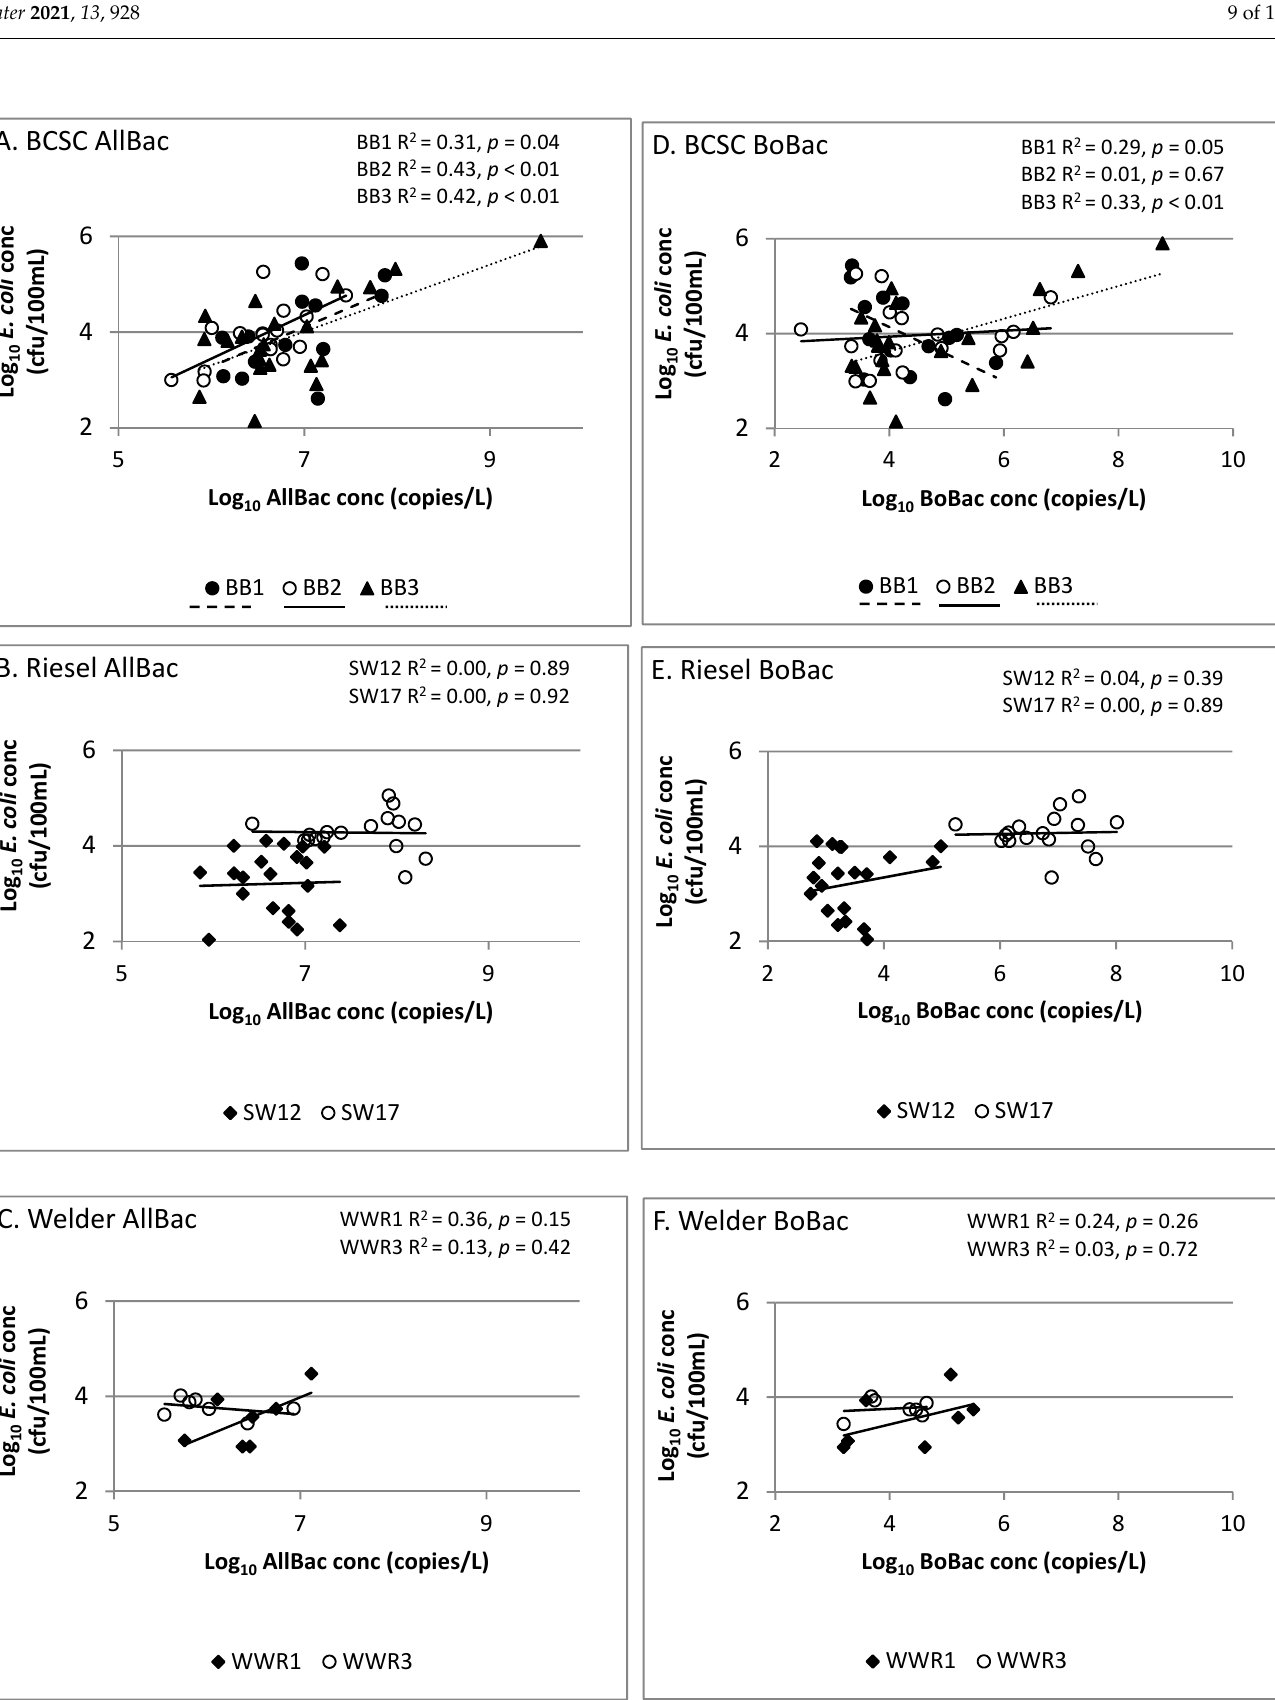
9 of 15 Figure 2. BoBac concentrations (copies/L) in runoff from grazing lands at each site when stocked and destocked. 3.3. Comparison of AllBac and BoBac Gene Copy Concentrations to E. coli Levels As compared to prior studies which found strong correlations between Bacteroides markers (including AllBac) and E. coli concentrations [14,17,30], our study found signifi- cant site-to-site variability in correlations between these parameters (Figure 3). The AllBac gene copy and E. coli concentrations were not correlated at Riesel (SW12, SW17) or Welder Wildlife Refuge (WWR1, WWR3) sites. In contrast, a moderate, statistically significant cor- relation was observed between AllBac gene copy concentrations and E. coli at all BCSC sites (BB1, BB2, BB3). This suggests that other factors are impacting the relationship at our sites. Correlations of Bacteroides markers and fecal indicator bacteria such as E. coli may be impacted by differences in detection methods (i.e., culture vs. molecular based) used for measuring each [14,15] and differences in survivability of each in the environment [31]. Quantitative PCR methods detect DNA from both culturable and unculturable or dead organisms, whereas the E. coli methods used detect only culturable cells [14,15]. This rela- tionship is further complicated by variability in both the prevalence of these organisms in various animal hosts that may be present at the sites and the survival of these organisms and markers in the environment [31]. However, research has demonstrated that little dif- ference exists in the decay rates of fecal Bacteroides 16S RNA genes in human, cattle, and